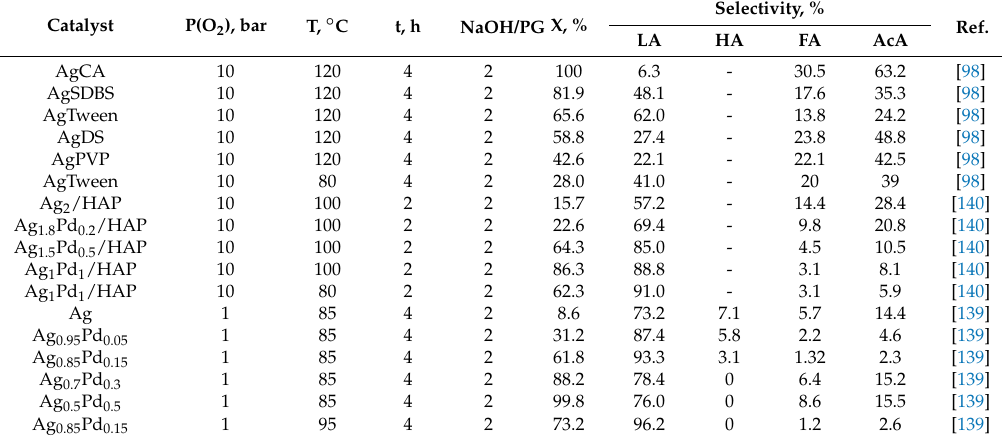
Table 5. Propylene glycol oxidation over silver-containing